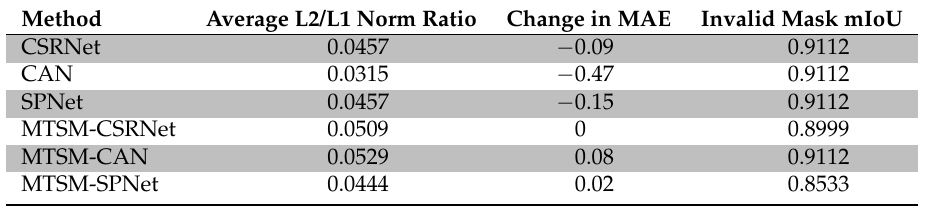
Table 4. L2/L1 norm ratio as compared to change in accuracy after masking for investigated